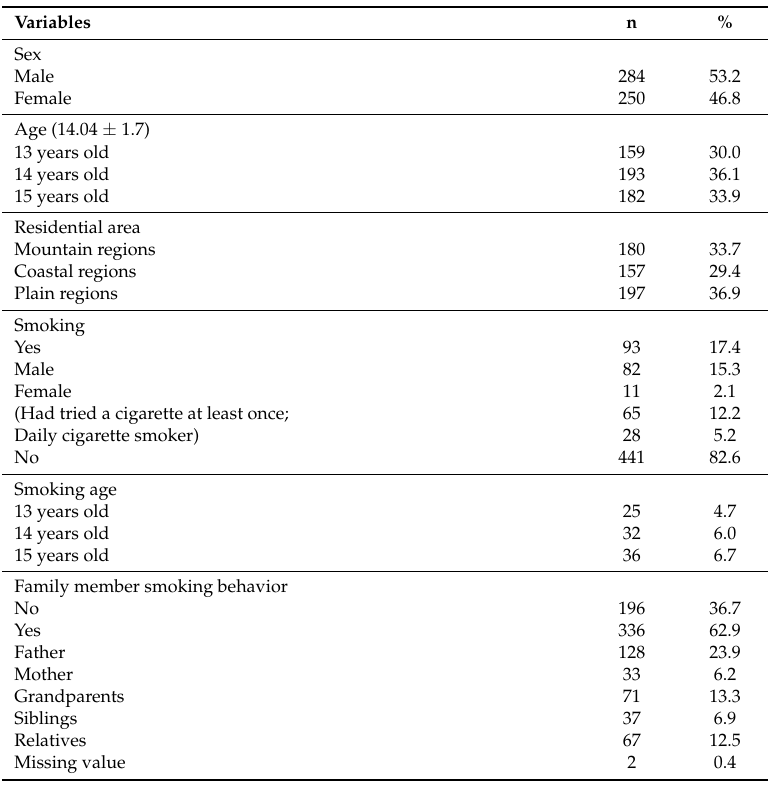
Table 3. Demographic data (n =